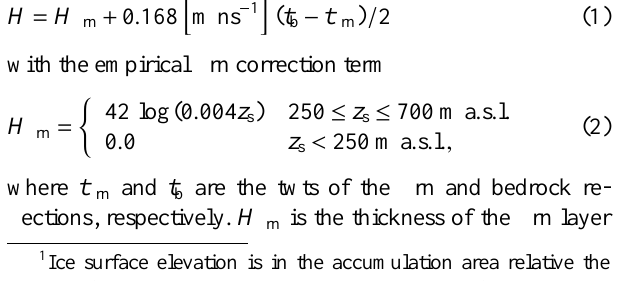
Figure 5. DEM of the interpolated ice surface topography z s in m (WGS84 ellipsoidal height) on King George Island (the contour line interval is 25m). The grey thick line shows the coastline. Database: Compilation of the groundbased survey (taken from Blindow et al. (2010)) and the airborne measurements. Background image is a © SPOT Image from 2000.